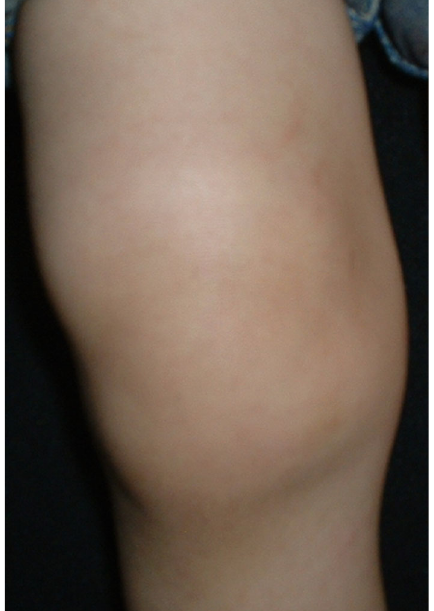
Figure 1: Unilateral knee e ff usion in a 4-year-old boy presenting to the pediatrician after an unwitnessed fall while playing in the yard.